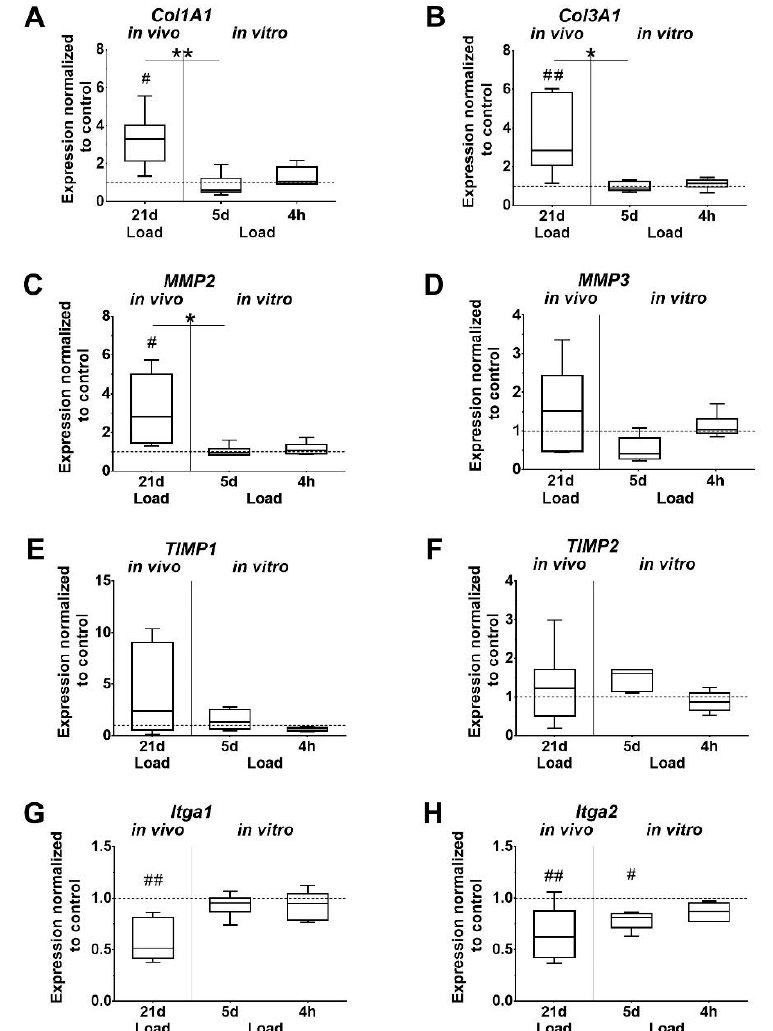
Figure 4. Mechanical loading influences the expression of ECM components. ( A , B ) Collagens, ( C , D ) matrix metalloproteinases (MMPs), ( E , F ) Tissue inhibitor of metalloproteinase (TIMPs), ( G , H ) Integrins. Gene expression is given as fold change to non-loaded controls (horizontal line). Significant difference to non-loaded control is marked with a pound sign and inter-group differences with an asterisk (#, *: p < 0.05; ##, **: p < 0.01, n = 6).